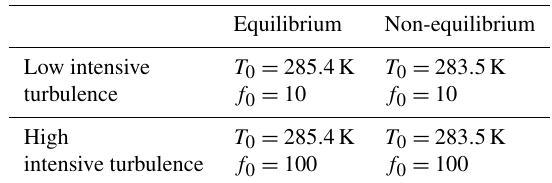
Table 2. The summary of key parameters for studying the effect of aerosol on turbulence. Equilibrium